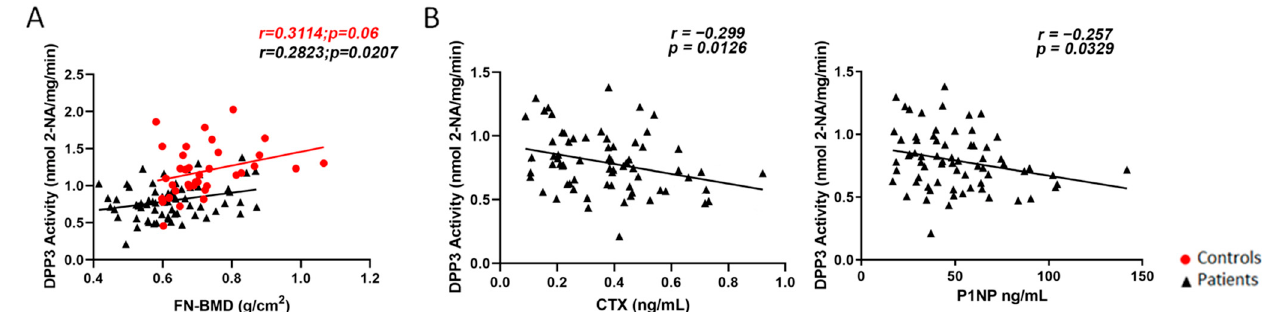
Figure 2. ( A ) Pearson correlation analysis (two-tail) between femoral neck BMD (FN-BMD) and circulating DPP3 activity in our cohorts of controls (depicted as red circles, n = 36) and patients (depicted as black triangles, n = 67); ( B ) Pearson correlation analysis (two-tail) between the bone turnover markers CTX (left) and P1NP (right) and circulating DPP3 activity in our cohort of osteoporotic women at baseline ( n = 69).